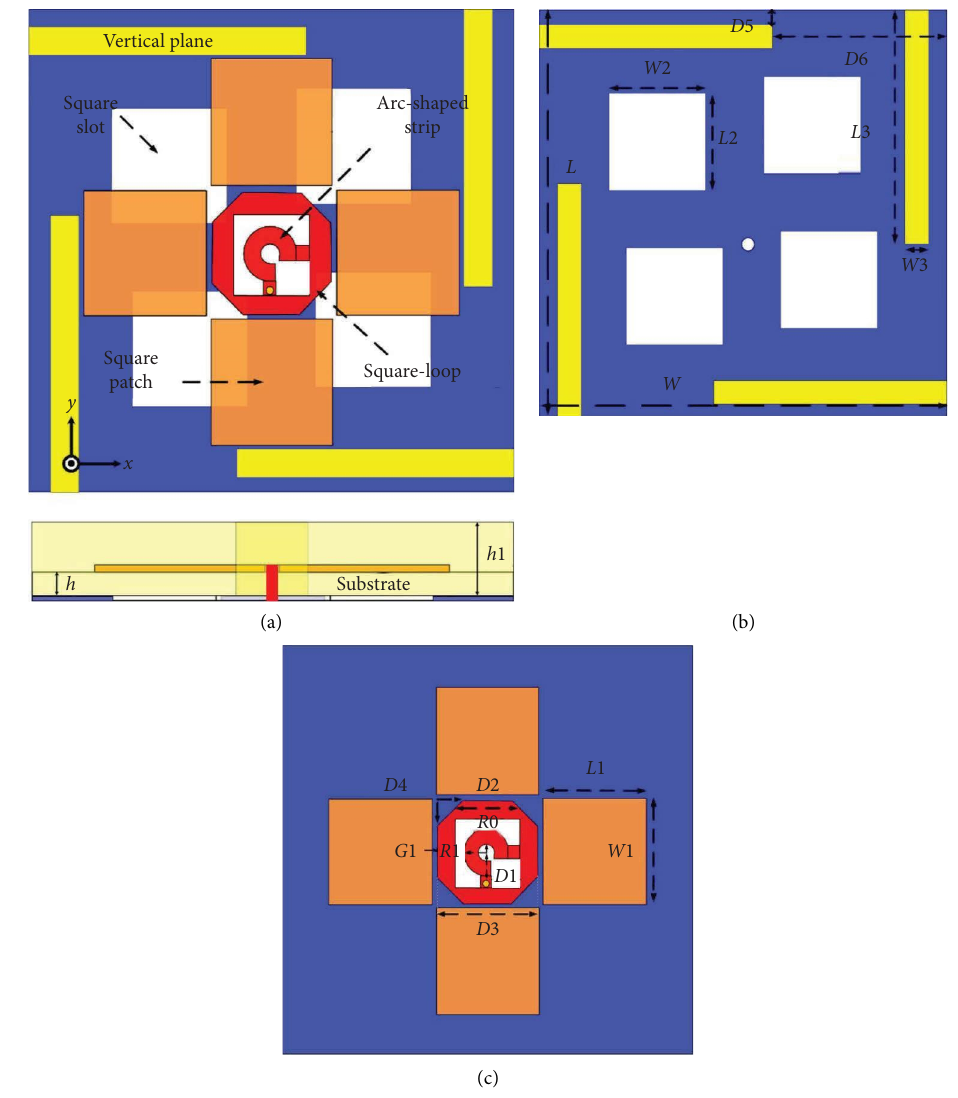
Figure 1: Geometry of the presented CP microstrip slot antenna. (a) Te overall structure, (b) the bottom view, and (c) the upper